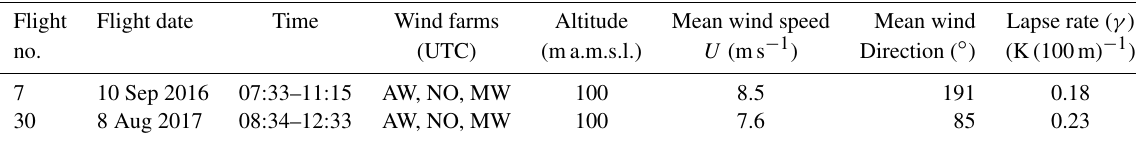
Table 2. Same as Table 1 but for the flights operated mainly downstream of the wind farm.